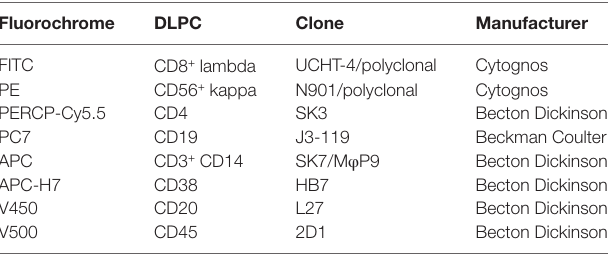
Table 1 | Antibodies used for staining in the cases of suspicion of lymphoproliferative disease.